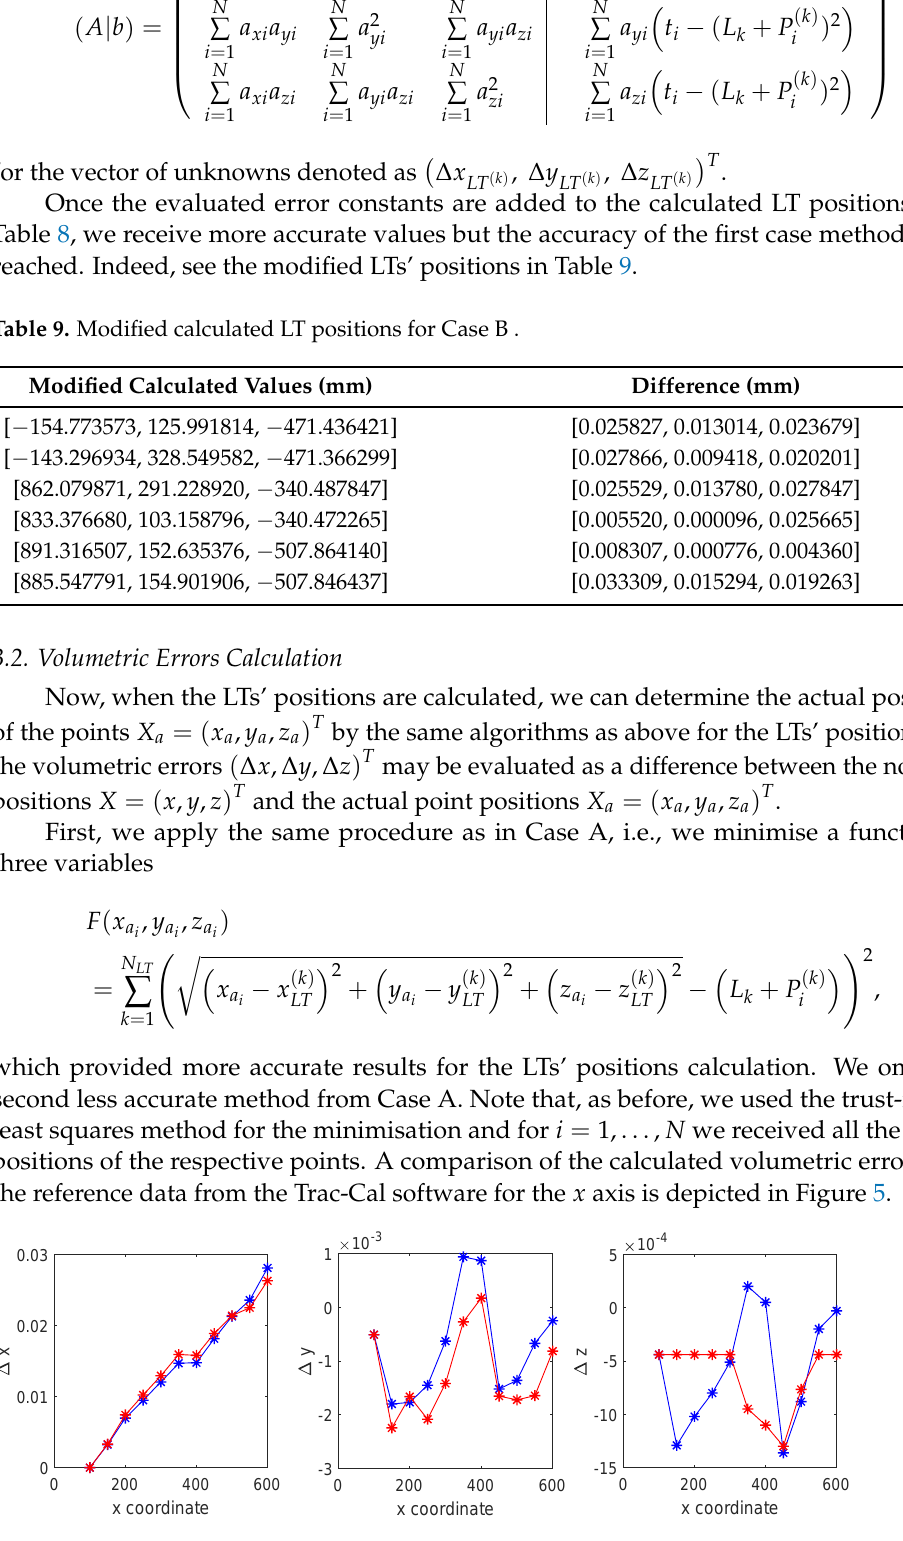
Figure 5. Comparison of ∆ x , ∆ y , ∆ z on the x axis, Trac-Cal results in blue, Case A in red. Units: